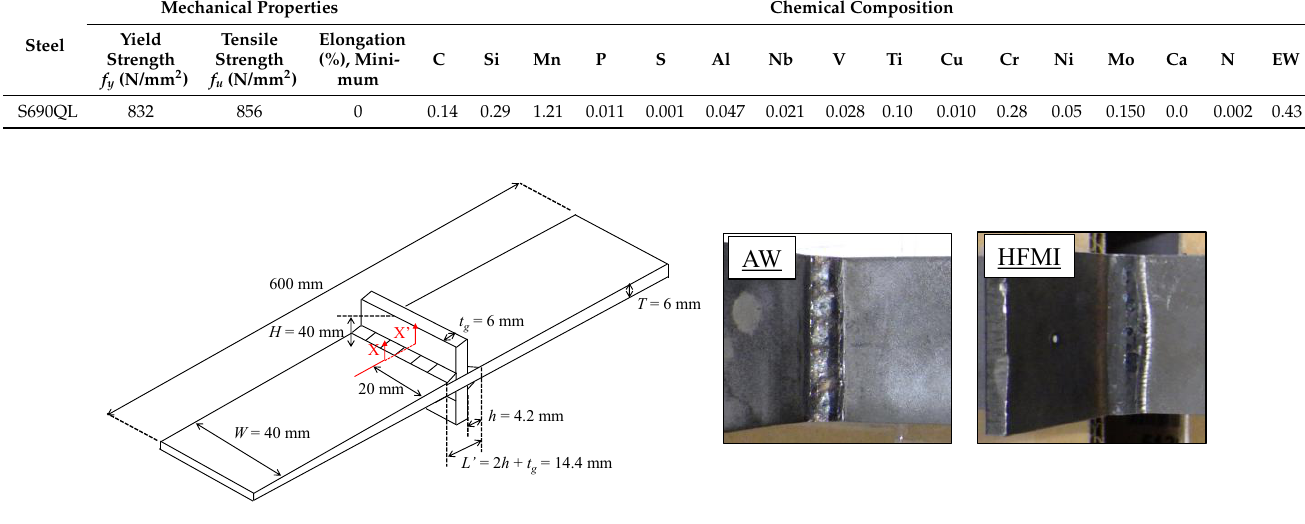
Figure 1. Configuration of the non-load-carrying attachments, Reprinted with permission from ref. [27]. 2021 International Journal of Fatigue (in axonometry and pictures showing weld